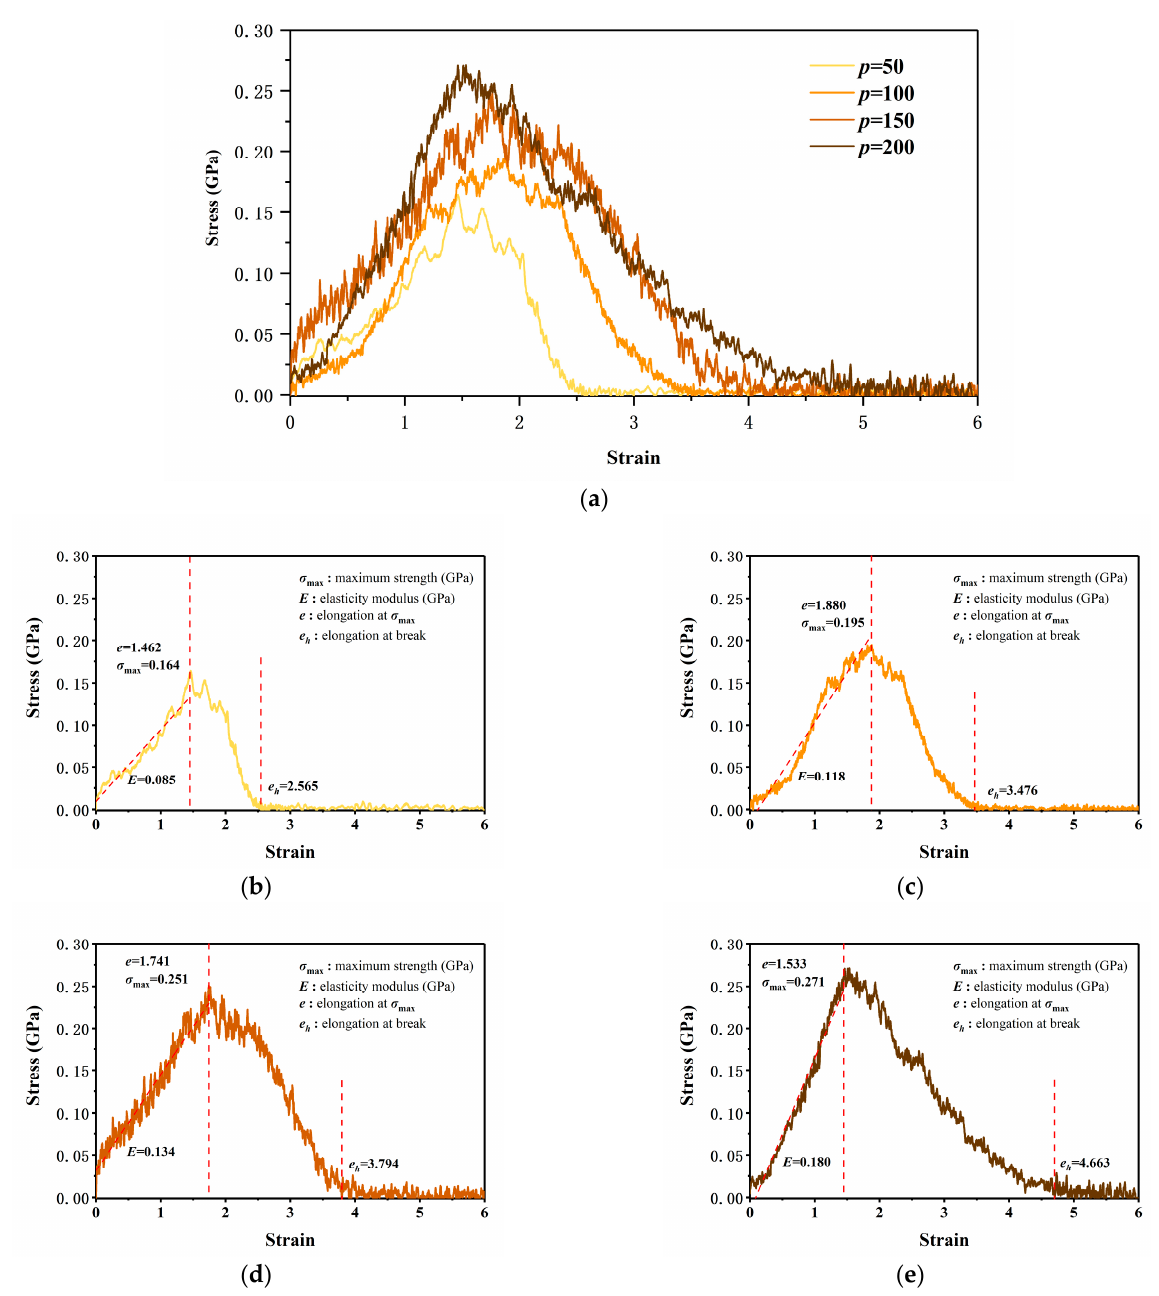
Figure 4. Stress–strain curve of PI: ( a ) overall; ( b ) p = 50; ( c ) p = 100; ( d ) p = 150; ( e ) p = 200.